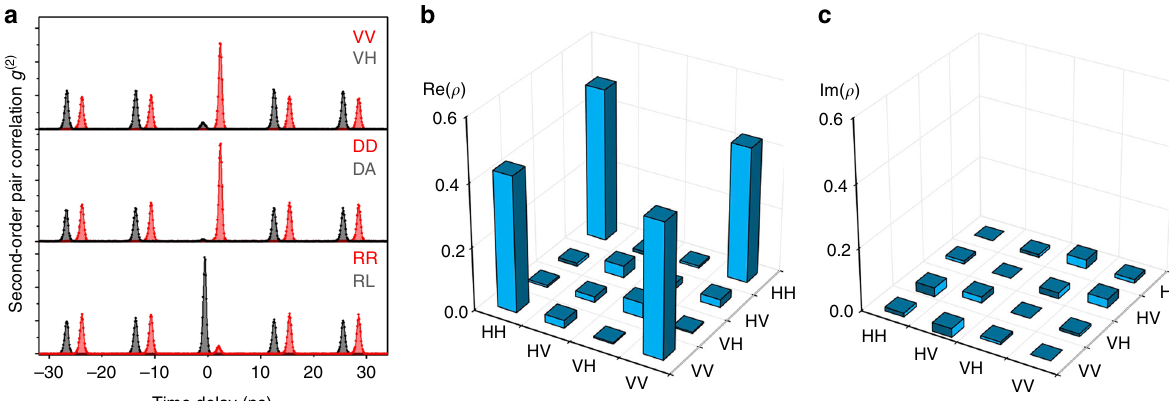
Fig. 3 Entanglement fi delity of a quantum dot with fi nite FSS. a XX-X cross-correlation measurements under resonant two-photon excitation for co- and cross-polarized photons in the rectilinear (H horizontal, V vertical), diagonal (D diagonal, A anti-diagonal) and circular (R right-handed, L left-handed) polarization bases. The graphs for co-polarized (red) and cross-polarized (black) photons are shifted by 3 ns for clarity. A fi delity F = 90% is extracted. b , c Real ( b ) and imaginary ( c ) parts of the two-photon density matrix as reconstructed from 16 correlation measurements of the same QD by employing the maximum likelihood technique. The fi delity extracted from this matrix is F = 89%